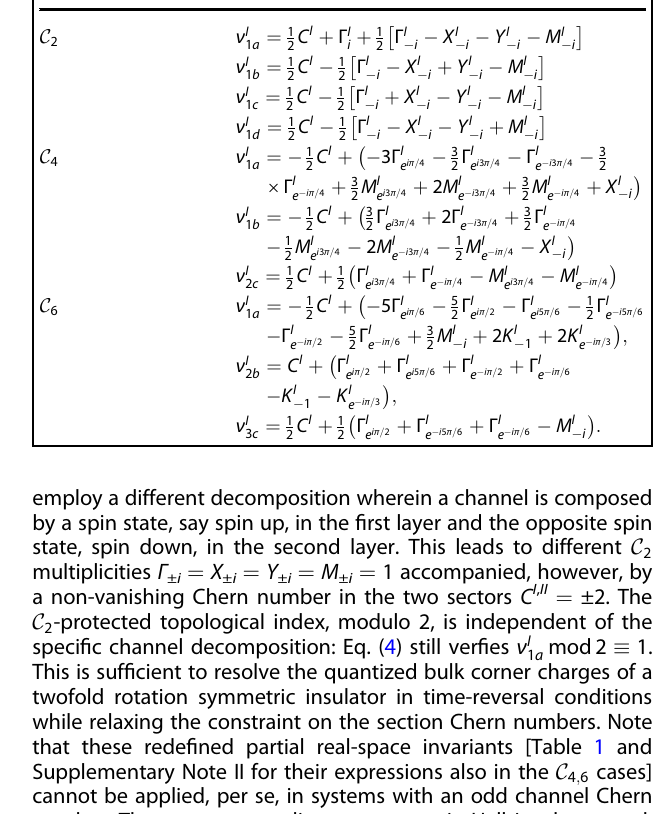
Table 1. Partial real-space invariants of rotation-symmetric two- dimensional